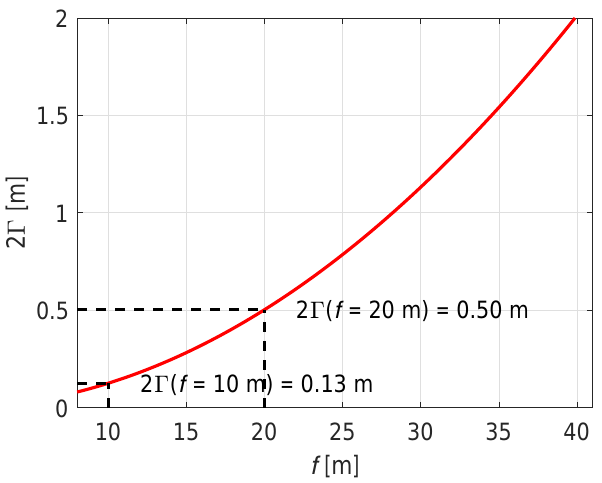
Figure 7. Relationship between focus distance and the probe